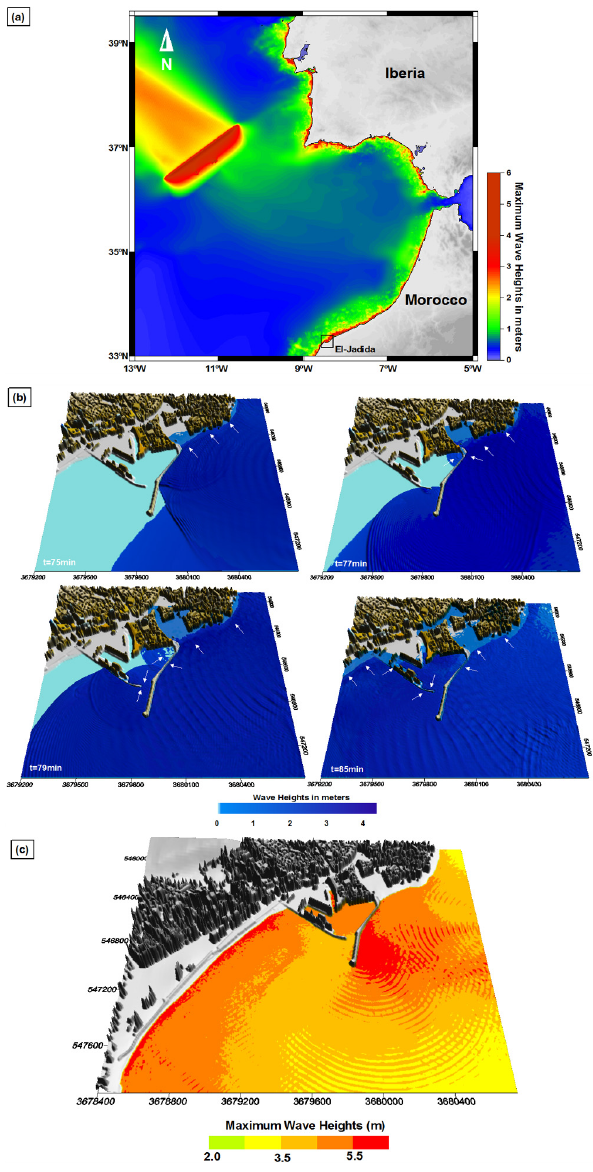
Fig. 8. Tsunami waves’ propagation and near-shore behaviour for the M w = 8 . 6 GB scenario: (a) regional tsunami energy patterns; (b) snapshots of near-shore tsunami propagation at El Jadida site; the white arrows indicate the overtopping locations; (c) maximum wave heights distribution near coasts and the harbour of the studied area.